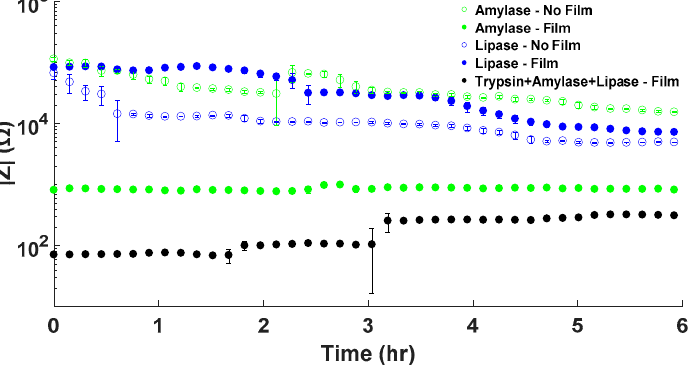
Figure 5. Representative impedance responses at 10 kHz of sensors, either uncoated or coated with a gelatin film, to trypsin, amylase, or lipase, each at 1 mg/mL, or combinations of each enzyme with trypsin. The error bars plot the temporal change in impedance at respective time points (span = 3).